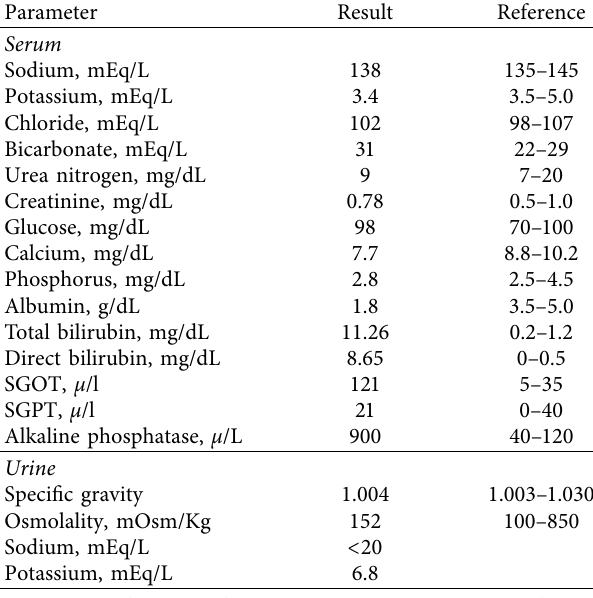
Table 1: Laboratory